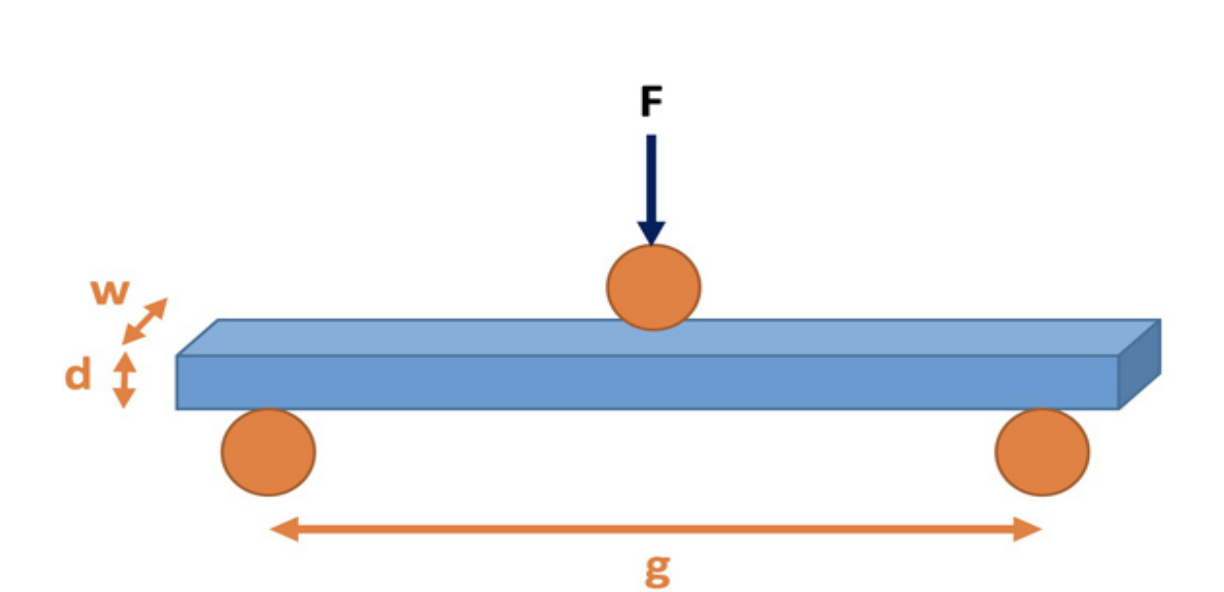
Figure 1. The three-point method set up used for bending and shears properties measurement.